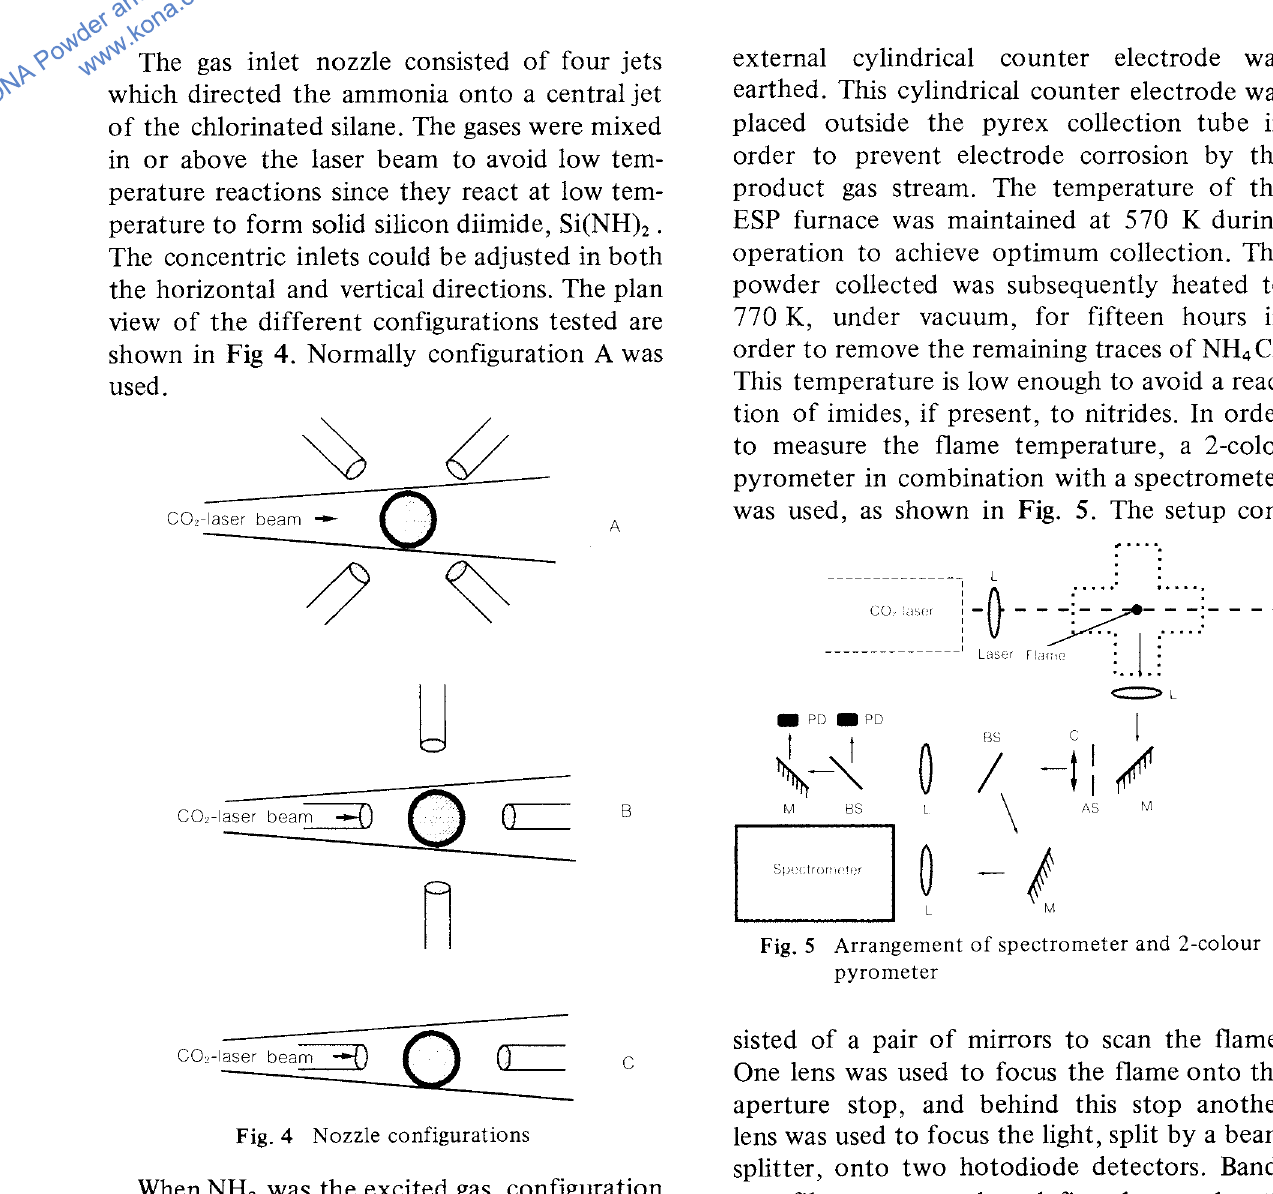
Fig. 5 Arrangement of spectrometer and 2-colour